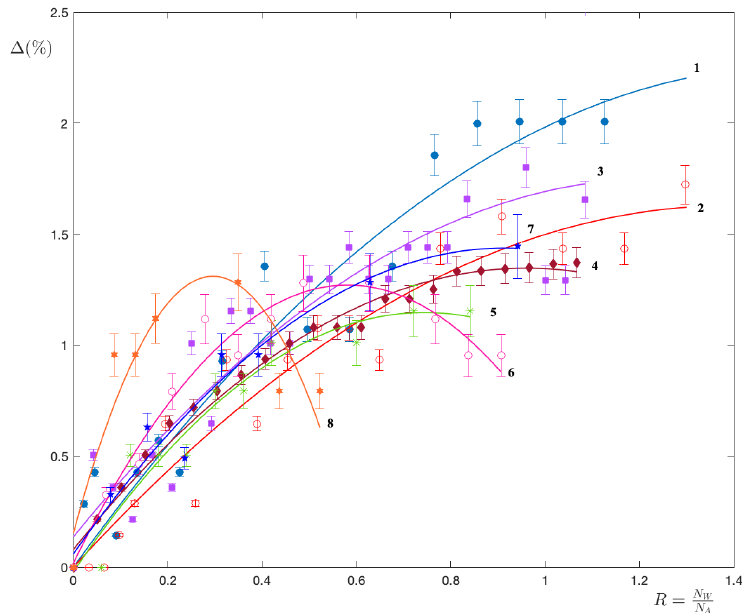
Figure 9. Average percent increase in the red shift of NR fluorescence in the ternary systems NR– n – alkanol–water, as a function of the parameter R . The number on the curves indicates the number of carbon atoms in the alkanol molecule.